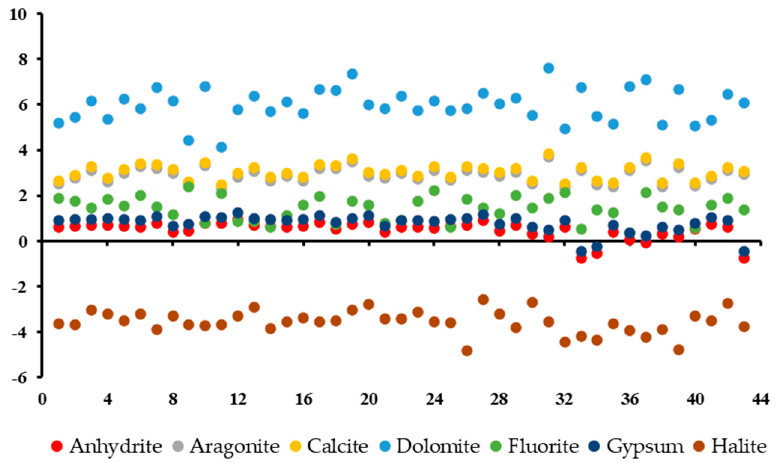
Table 6. Description statistical analysis of chloro-alkaline and saturation indices.